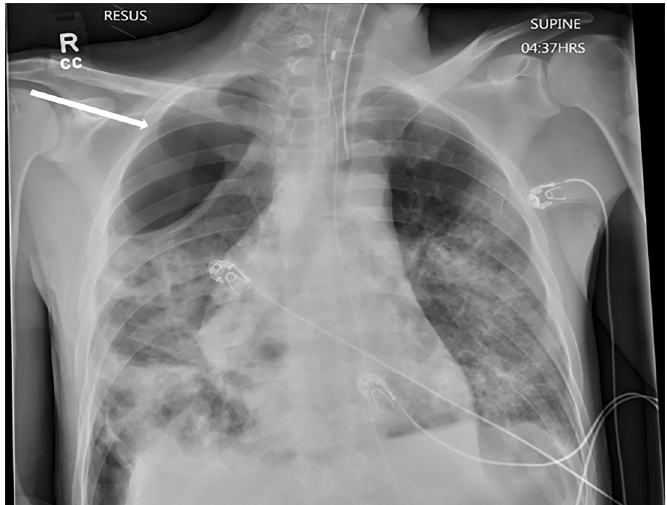
Image 2. Thorax computed tomography coronal plane demon- strating right upper lobe gigantic bulla (black arrow) as well as multifocal pneumonia with bronchiectasis (multiple white arrows).